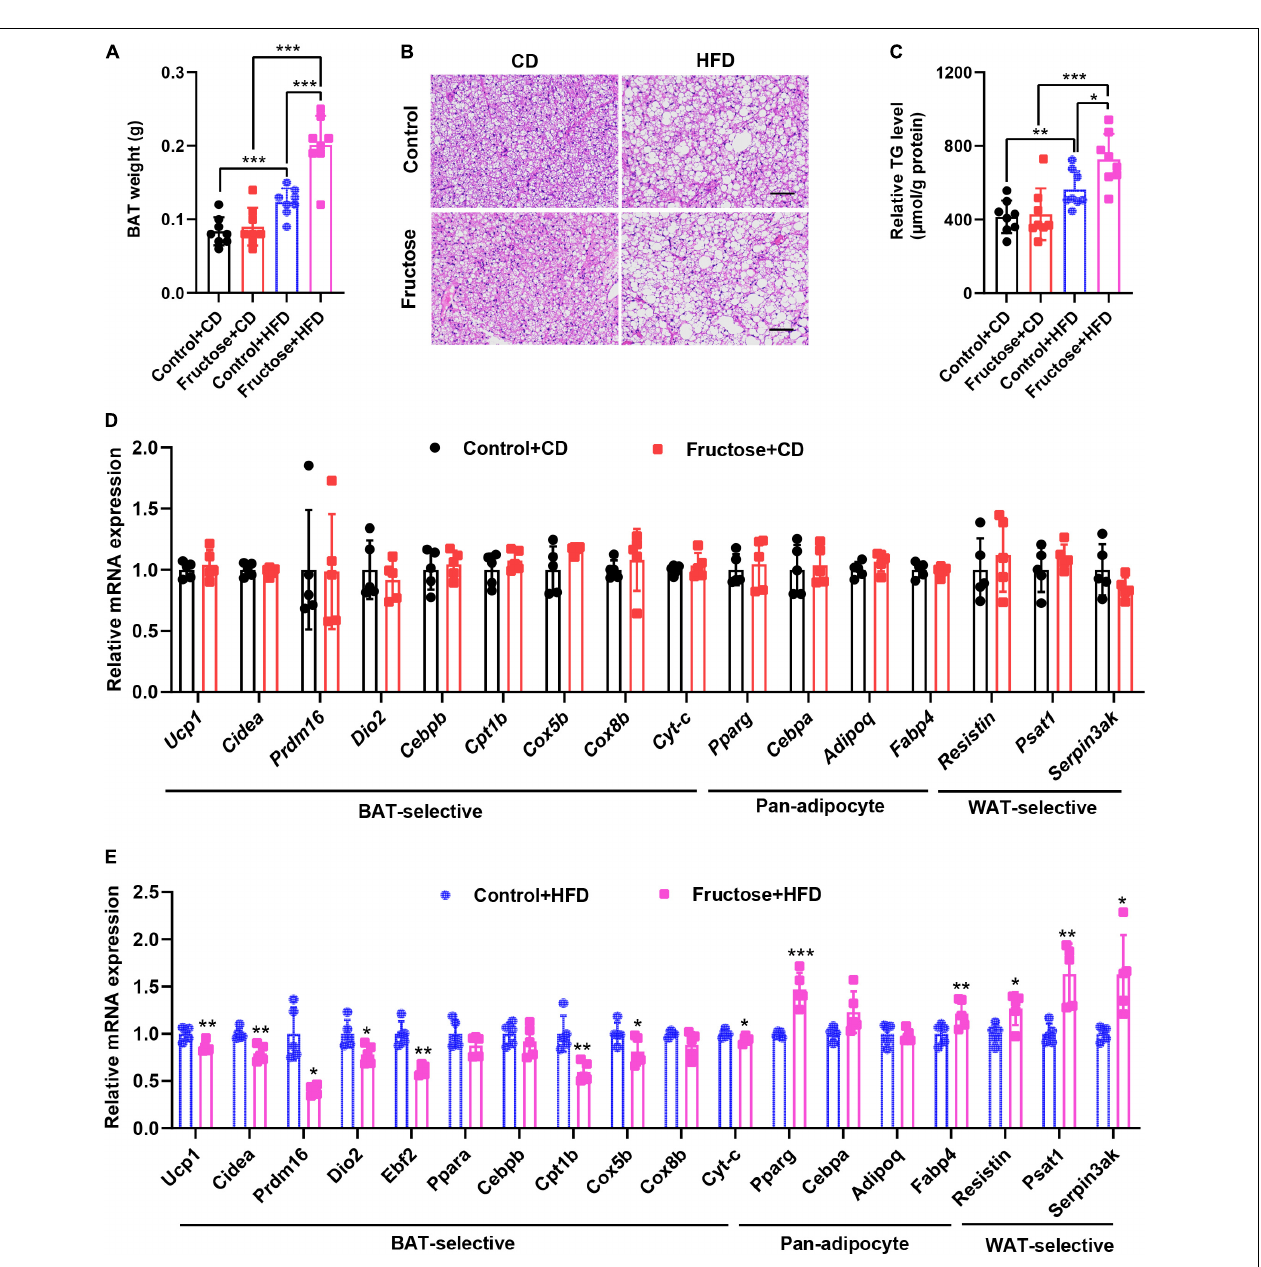
FIGURE 4 | High-fat diet-induced thermogenic program of brown fat is attenuated in adult offspring of dams fed with high fructose. (A) The weight of BAT tissue in CD-fed or HFD-fed control offspring or HF offspring. (B) H&E staining of paraffin sections of BAT. Scale bar, 100 µ m. (C) Quantification of triglyceride content in BAT ( n = 8). (D) qRT-PCR analysis of BAT-selective genes, pan-adipocyte genes, and WAT-selective genes in BAT from CD-fed control offspring or HF offspring ( n = 5). (E) qRT-PCR analysis of BAT-selective genes, pan-adipocyte genes, and WAT-selective genes in BAT from HFD-fed control offspring or HF offspring ( n = 5). * p < 0.05, ** p < 0.01, *** p <